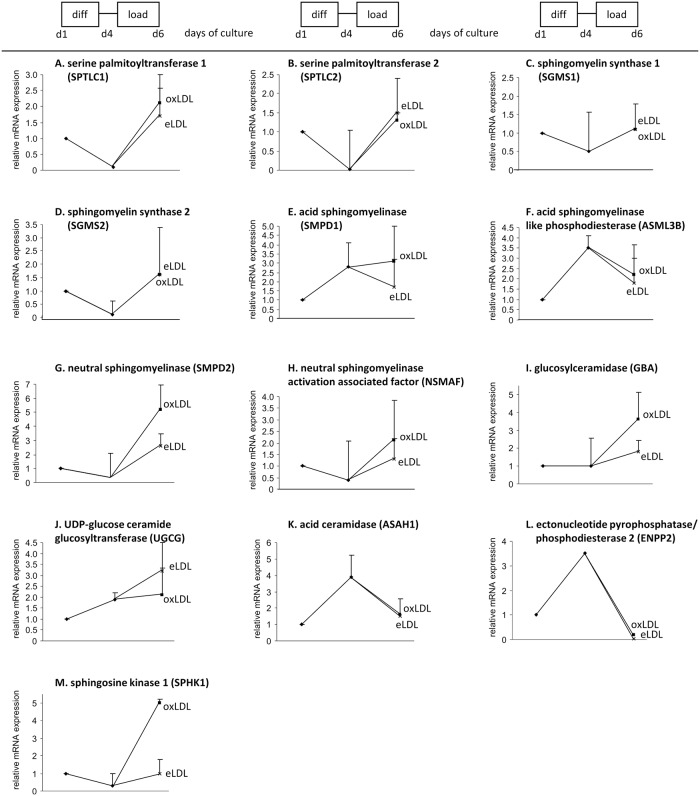
Taqman RT-PCR analysis of enzymes mainly involved in sphingolipid biosynthesis and metabolism.Gene expression was monitored of 4 day differentiated macrophages and of 48 hours eLDL and oxLDL loaded macrophages (day 4 to day 6. RT-PCR was standardized to 18s rRNA as a reference. mean + SD. n = 3.